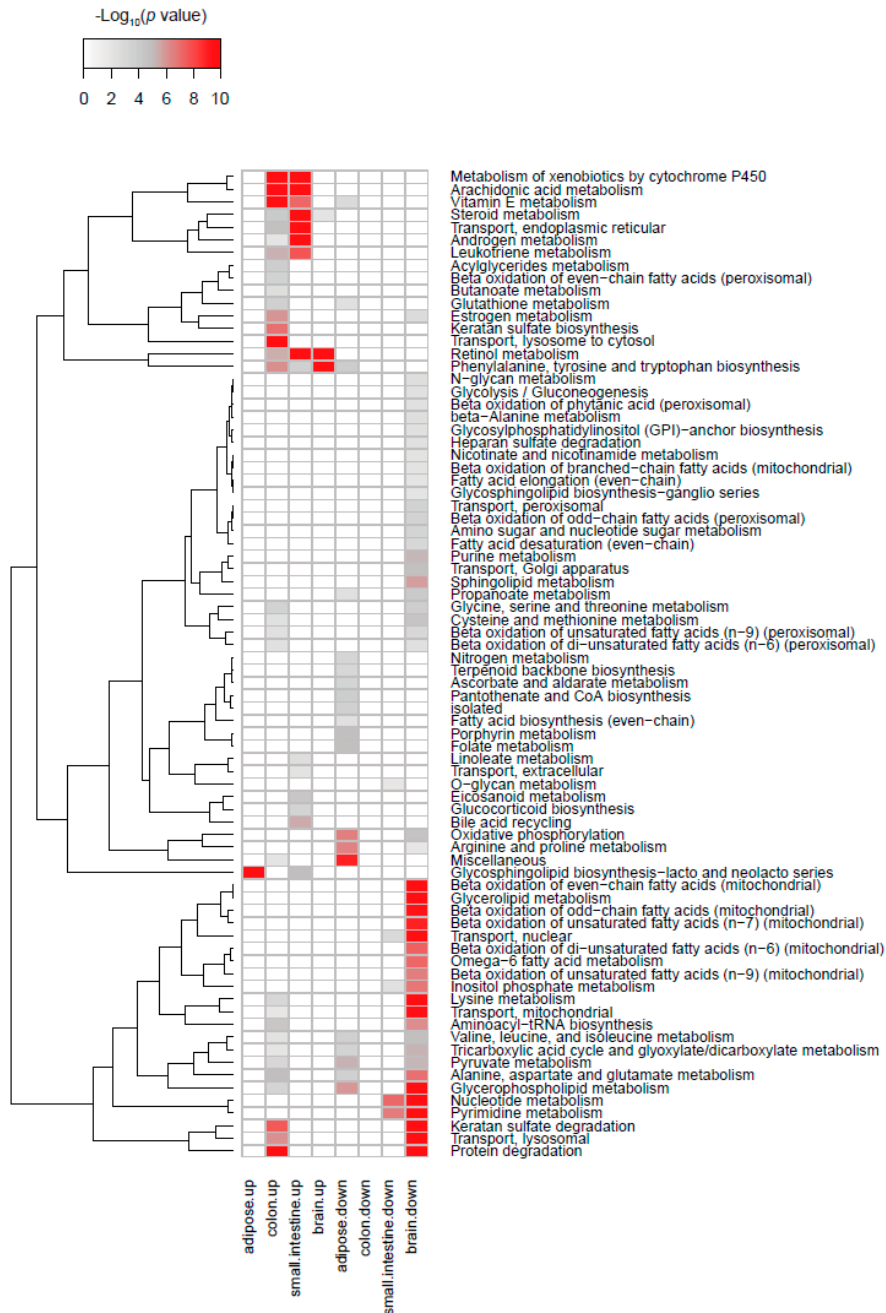
Figure 6. Predicted metabolic pathways according to TPH1 (adipose tissue, colon, and small intestine) and TPH2 (brain). Figure is the heatmap with the significant changes in metabolic pathway when the high TPH groups were compared with low TPH groups ( n = 10 per each group). Up: upregulated pathways in high TPH tissue. Down: downregulated pathways in high TPH tissue.